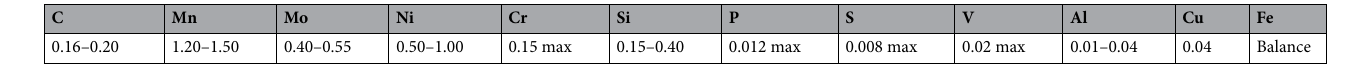
Table 1. Chemical composition (in wt.%) of the low alloy steel used in this